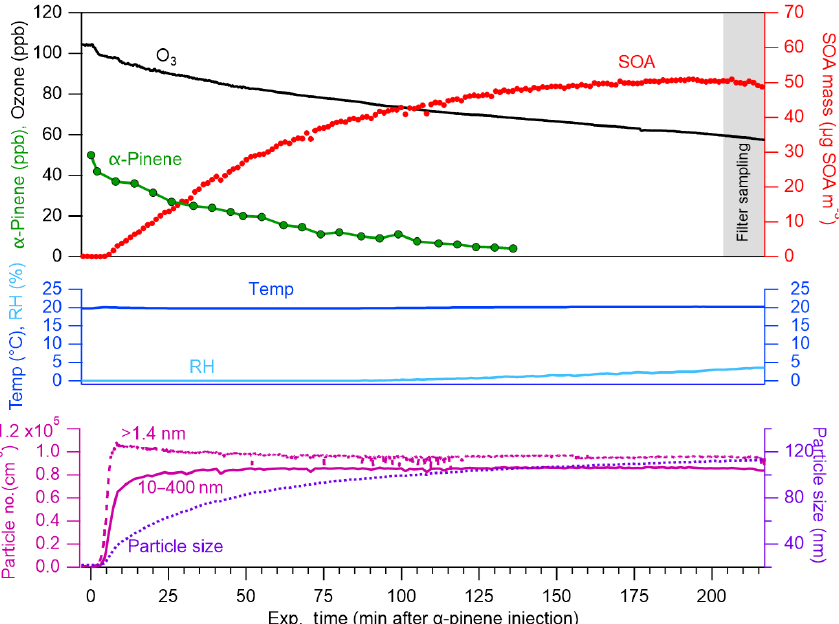
Figure 1. Concentration of O 3 (ppb; black), α -pinene (ppb; green), wall-loss-corrected SOA mass (µgm − 3 ; red) and particle number con- centration (no.cm − 3 ; measured by PSM, for > 1 . 4nm, and SMPS, for 10–400nm; dark red), and the geometric mean particle size (nm; by SMPS; violet) along with recorded RH (%; teal) and temperature ( ◦ C; blue) during a 50ppb α -pinene oxidation experiment performed at 20 ◦ C (Exp.